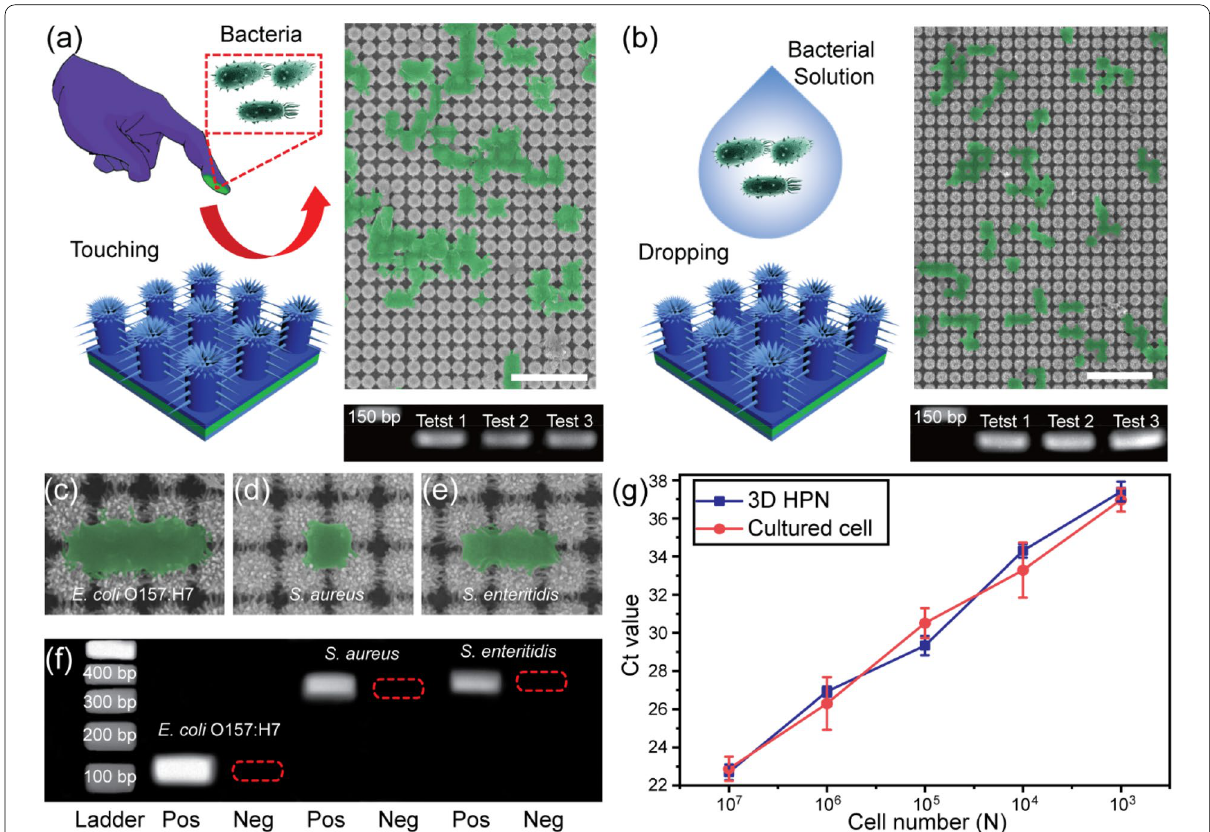
Fig. 5 Comparison of bacteria‑capturing capabilities of the 3D HPN by a touching and b dropping method. SEM images showed that E. coli O157:H7 cells were attached to the 3D HPN. The genomic DNA of captured E. coli O157:H7 on the 3D HPN was amplified in PCR, and amplicons were analyzed by gel electrophoresis. Verification of the versatility of the 3D HPN for three model pathogens covering Gram‑positive and Gram‑negative bacteria of c E. coli O157:H7, d S. aureus , and e S. enteritidis . f Gel electrophoresis results of the three pathogens. g Real‑time PCR results of captured E. coli O157:H7 cells in the finger‑touching method and cultured cells in LB broth without recovery step from the 3D HPN at a cell number of 10 3 ‒ 10 7